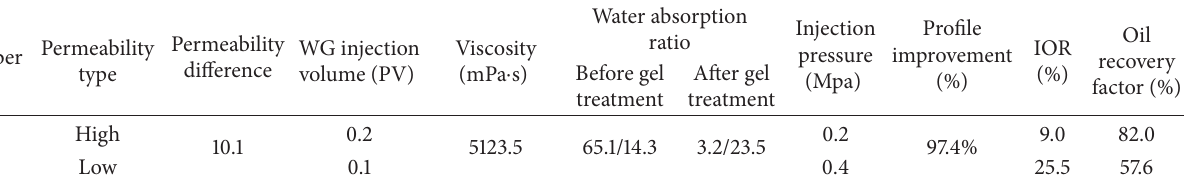
Table 3: Results of weak gel profile modification and oil displacement (70 ∘ C).